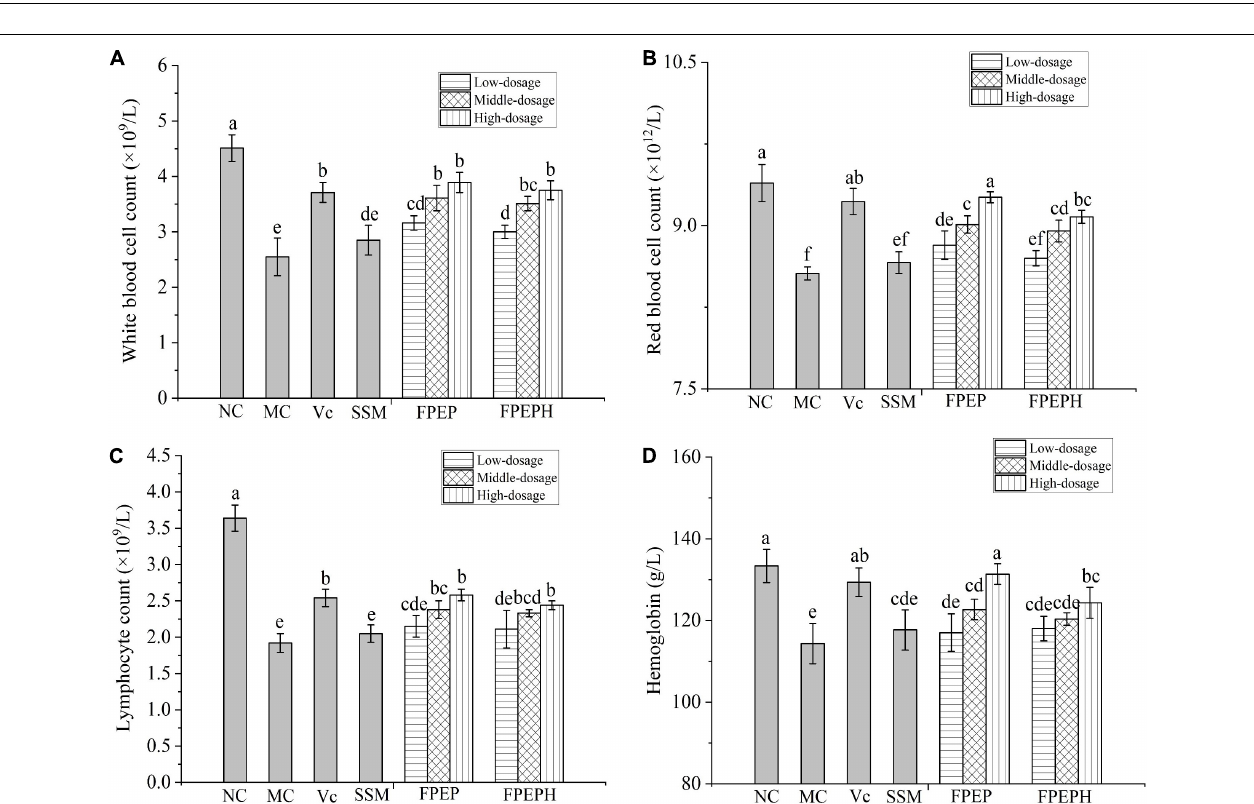
FIGURE 2 | Effects of sour soybean milk on organ index in mice. (A) Spleen index, and (B) thymus index. Data were presented as the Mean ± S.D. The same letters indicated no significant differences and different letters indicated significant differences at P < 0.05. NC: control group; MC: model group; Vc: vitamin C-ascorbic acid; SSM: sour soybean milk; FPEP: fermented with P. eryngii polypeptides with a molecular weight of < 3 kDa; FPEPH: fermented with P. eryngii protein hydrolysate.